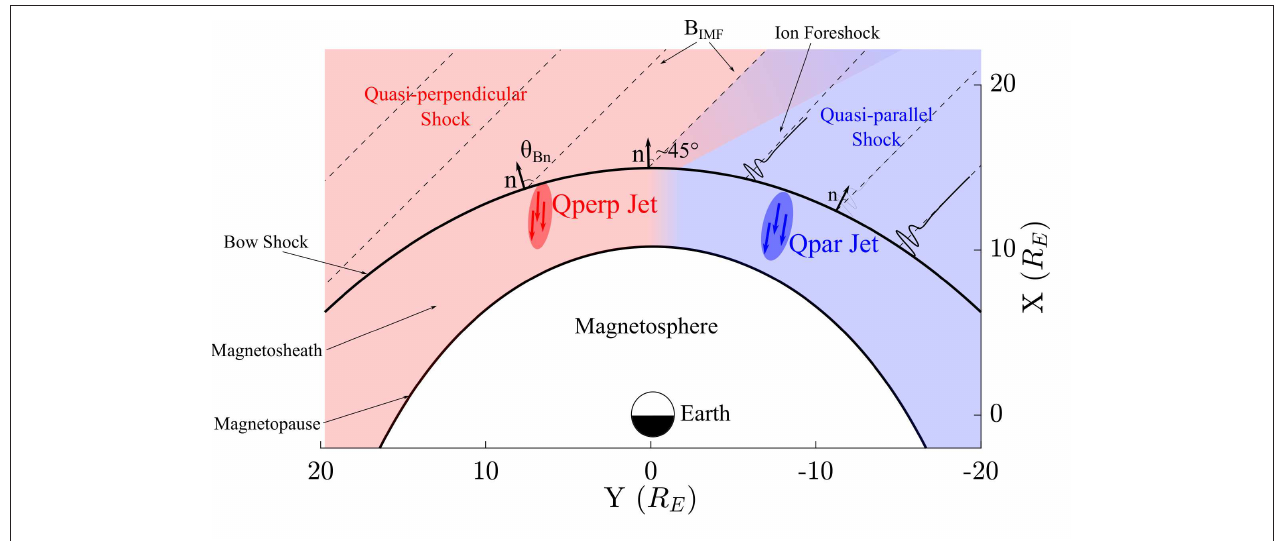
FIGURE 1 | Sketch of the bow shock and its different configuration in the Earth’s environment. An Interplanetary Magnetic Field (IMF) with an angle, approximately 45 ◦ with the normal at the nose of the bow shock is assumed. As a result, a quasi-perpendicular ( θ Bn > 45) shock takes place on the left part of the image and a quasi-parallel ( θ Bn < 45) on the right. The instabilities caused by the reflected ions in the Qpar case create the so called ion foreshock which changes drastically the properties between the Qpar shock and the Qperp